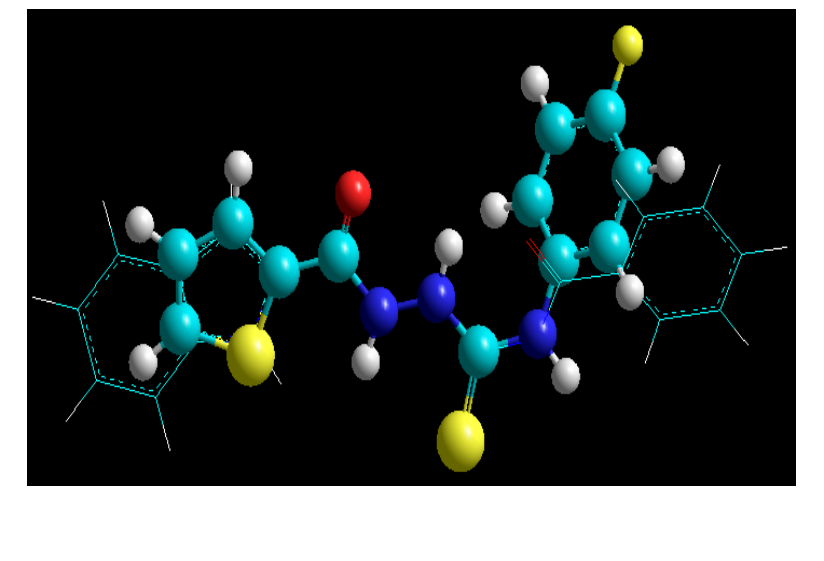
Figure 4. Overlay of the structures of known S. aureus topoisomerase IV inhibitor ( tubes ) [39] and 4-(4-fluorophenyl)-1-(thiophen-2-yl)carbonylthiosemicarbazide 1g ( balls and sticks